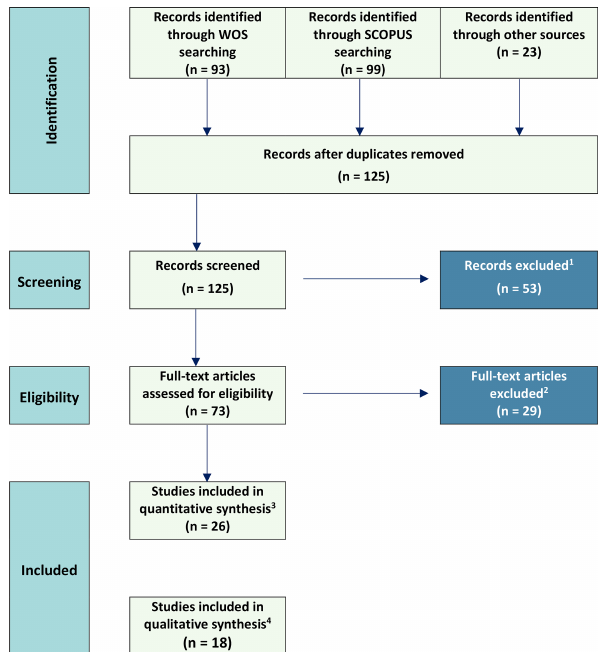
Figure 1. PRISMA (Preferred Reporting Items for Systematic Re- views and Meta-Analysis) flow chart (Moher et al., 2009) for article selection. 1 Records excluded concerning (a) flood mortality of ei- ther vegetal or animal species or (b) the long-term effects of floods on people. 2 Articles excluded because they were not relevant to the research (see the text for an explanation). 3 Articles listed in Table 1. 4 Articles listed in Table 2 and quoted in the